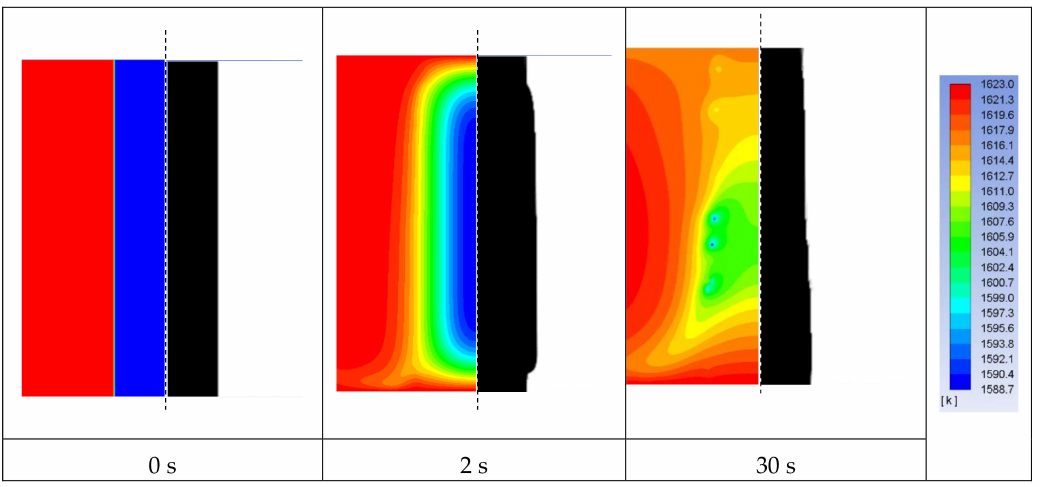
Figure 10. The diameter change and temperature distribution of the bar during the melting